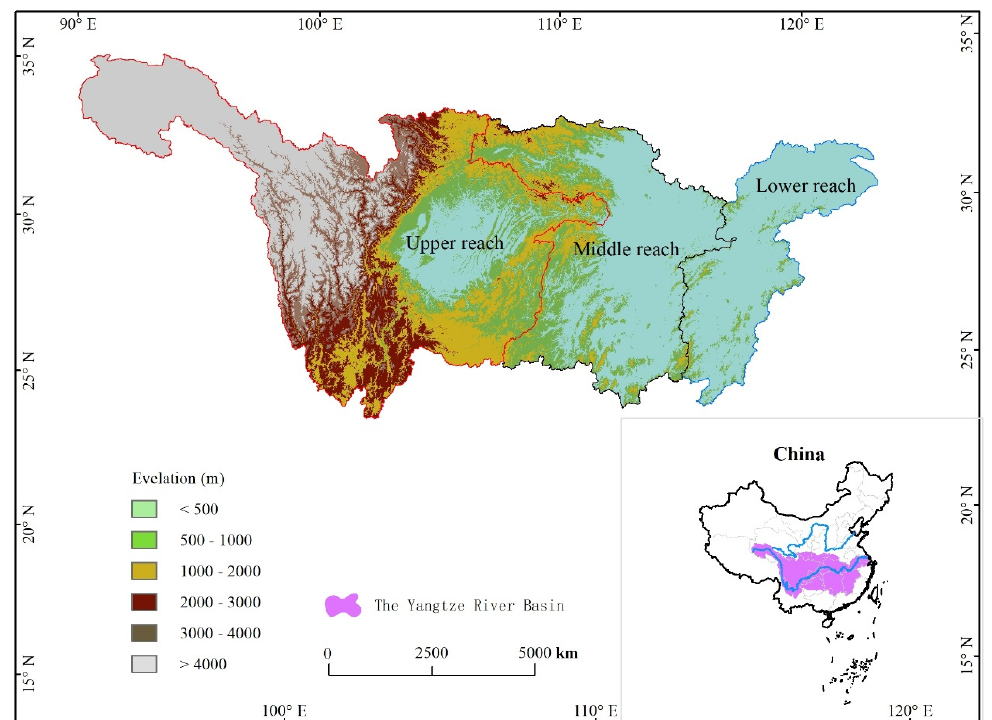
Figure 1. Location of the study area.